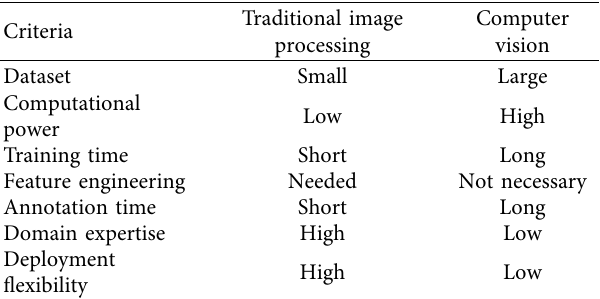
Table 1: Traditional vs. computer vision comparison based on